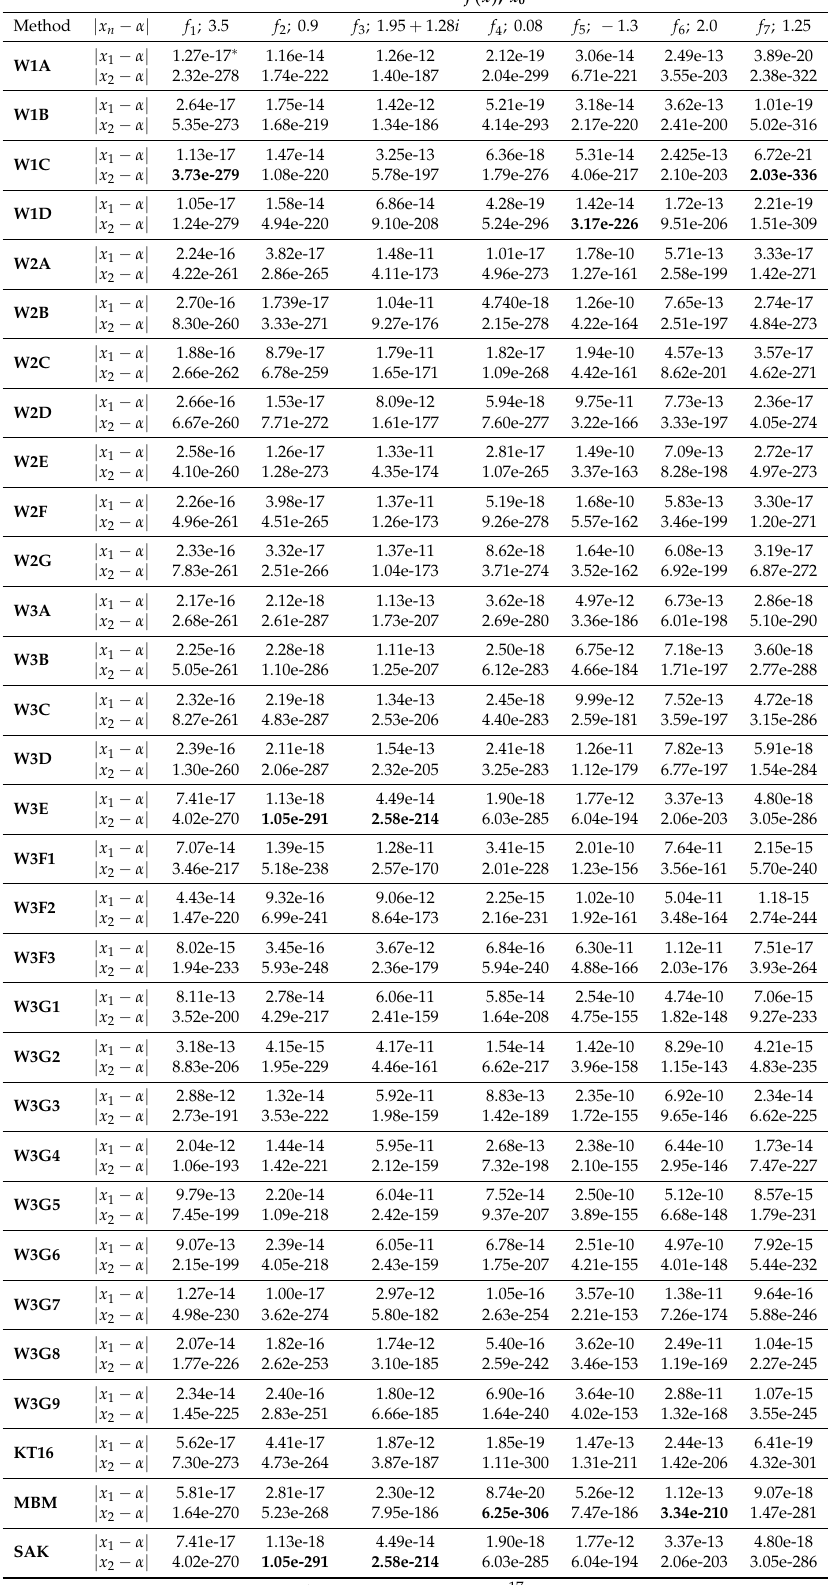
Table 4. Comparison of | x n − α | for selected methods applied to various test